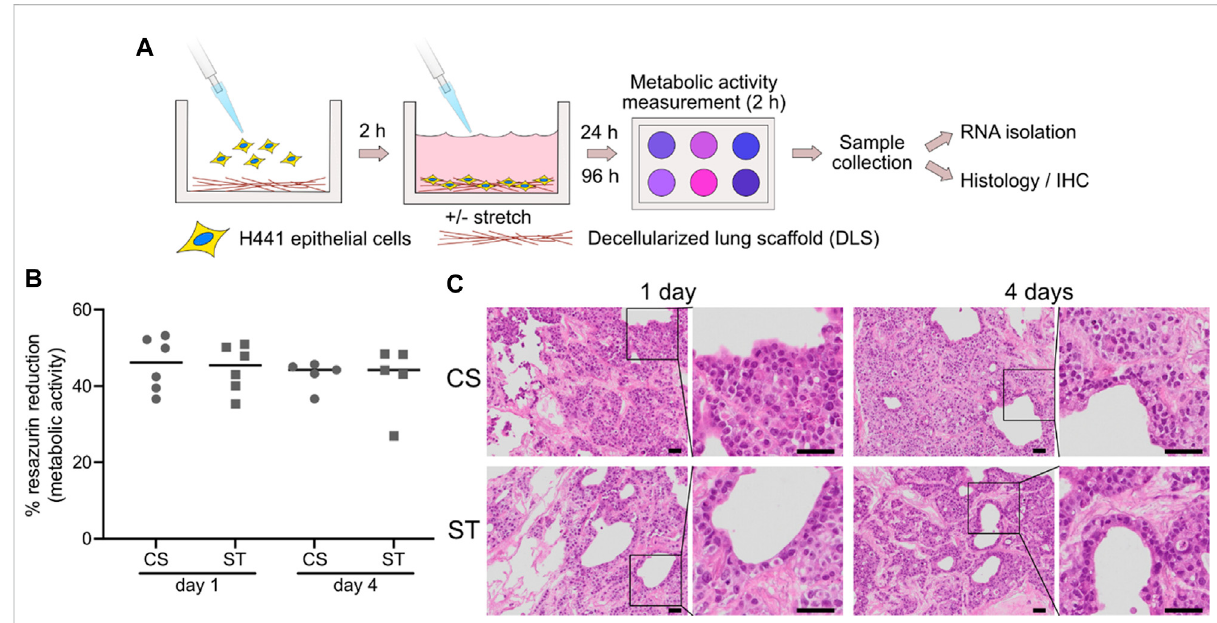
FIGURE 2 Experimentaloverviewandlungslicerepopulation.H441cellswereseededintowellswithmountedDLSandexposedtomechanicalstimulifor 1or4 days,afterwhich sampleswerecollected (A) .Cellmetabolismwasevaluatedafter 1and4days ofculturebyaresazurin-basedreductionassay (B) . CS: cyclic stretch (circles), ST: static culture (squares). Data points represent data from individual lung slice samples ( n = 6 for both conditions at day 1, and n = 5 at day 4), horizontal lines show group median. Representative images of hematoxylin and eosin (H,E) stained repopulated lung slices after 1 and 4 days of culture, with (CS) or without (ST) cyclic stretch (C) . Scale bars are 50